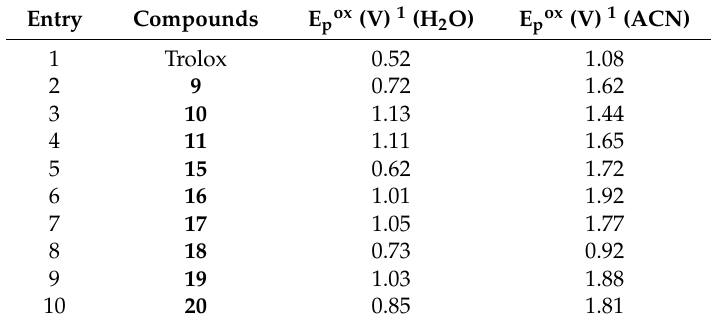
Table 6. First oxidation peaks (E pox ) from CV in aqueous medium and acetonitrile relative to compounds 9 – 11 and 15 – 20 (Figures 3 and 4).